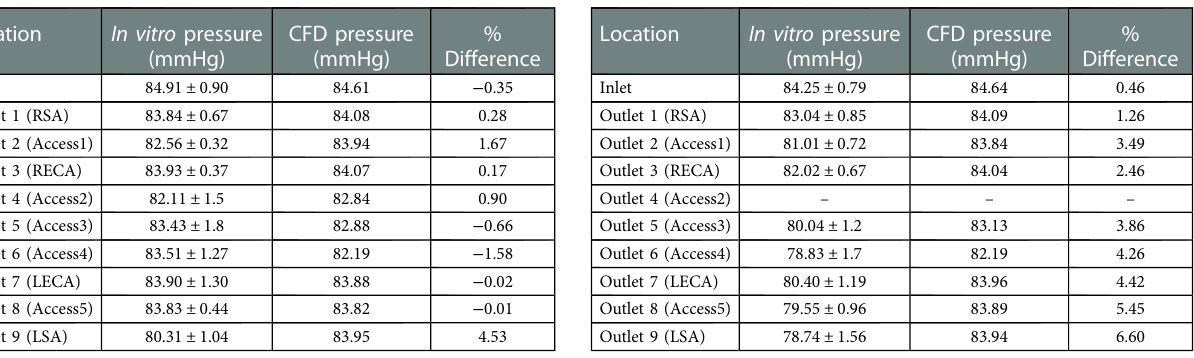
TABLE 3 Mean pressure (mmHg) obtained from in vitro experiments and CFD at the inlet and outlets for the stroke condition. The experimental values are reported as mean±standard deviation (SD) from three experiments.